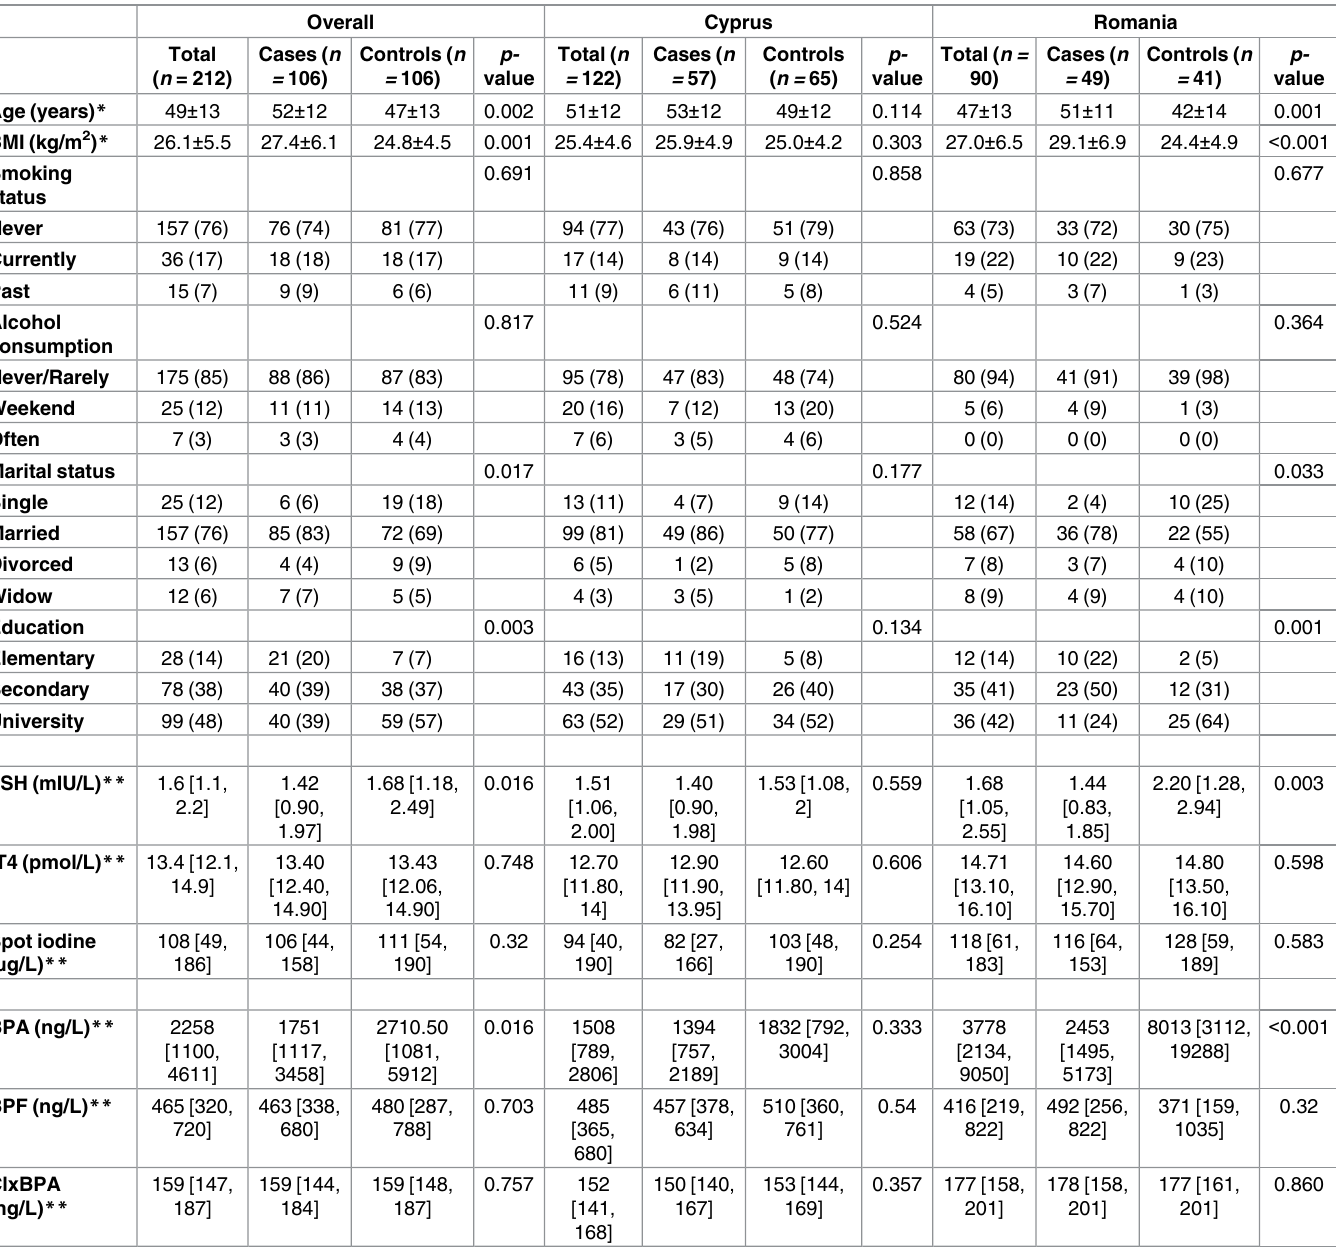
Table 1. Descriptivestatistics of the case and control group and all the participants (from both study